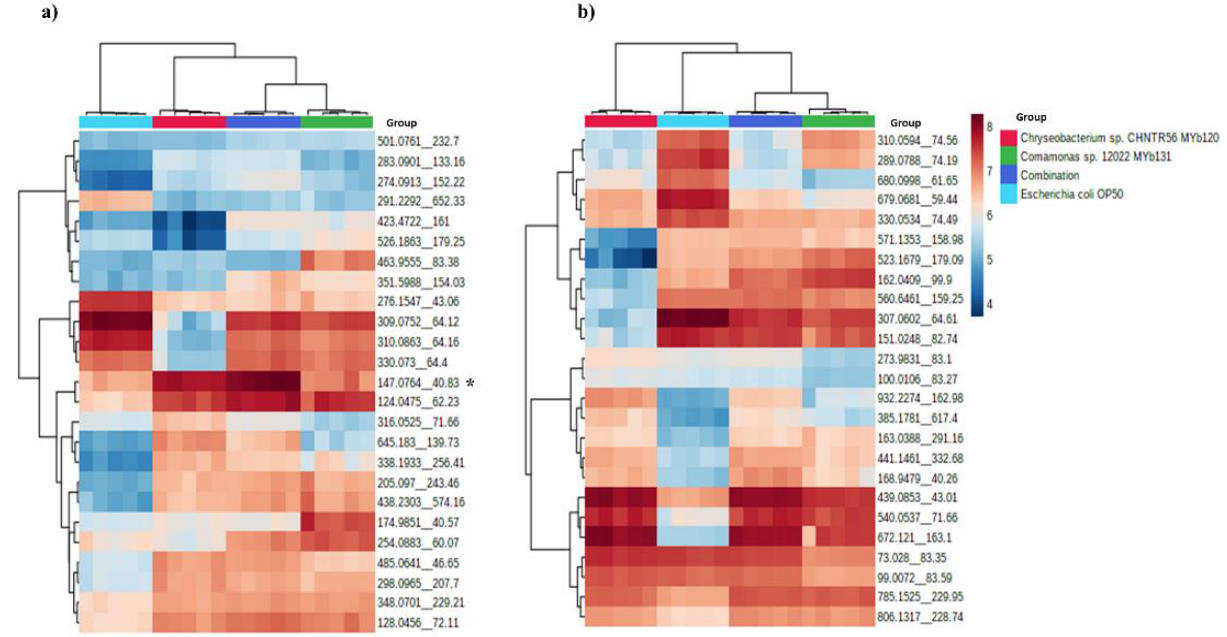
Figure 5. Heatmap of the top 25 significant features identified in positive ( a ) and negative ( b ) modes. The relative abundance of the feature ( m/z = 147.0764), indicated with asterisk (*), is specifically promoted in the combination group in positive